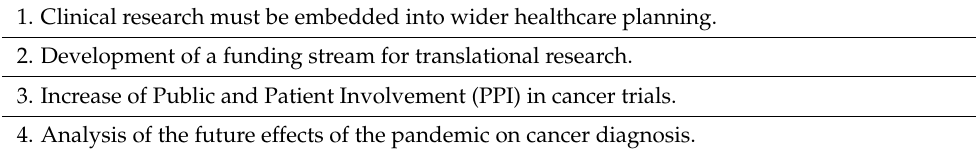
Table 2. Recommendations from the Cancer Retreat.